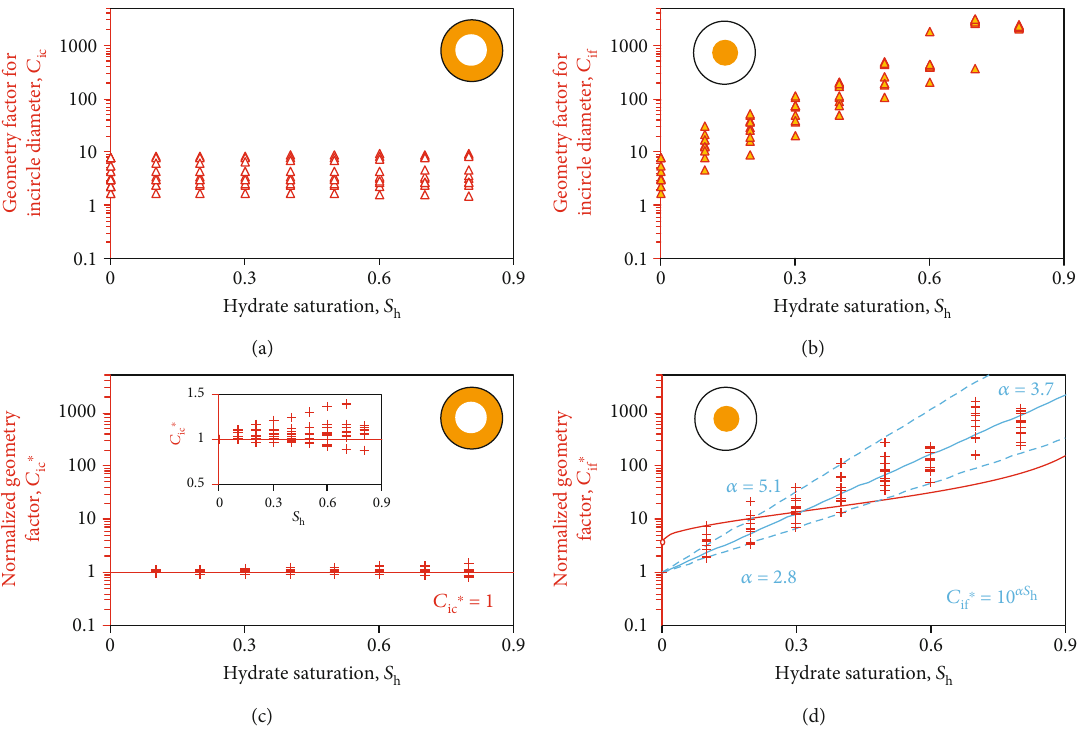
∗ for incircle diameter evolving with hydrate saturation S c Figure 7: Geometry factors c i and normalized geometry factors i factor for incircle diameter c ic in porous media containing grain-coating hydrates. (b) Geometry factor for incircle diameter c if in porous media containing pore- fi lling hydrates. (c) Normalized geometry factor for incircle diameter c ic ∗ in porous media containing grain-coating hydrates. (d) Normalized geometry factor for incircle diameter c if ∗ in porous media containing pore- fi lling hydrates. The red curve is p ffiffiffiffiffi p ffiffiffiffiffi ∗ = 1 at S Þ / ð 1 − S Þ when S S > 0 , and c = 0 drawn by c if ∗ = 4 ð 1 + h h h if h